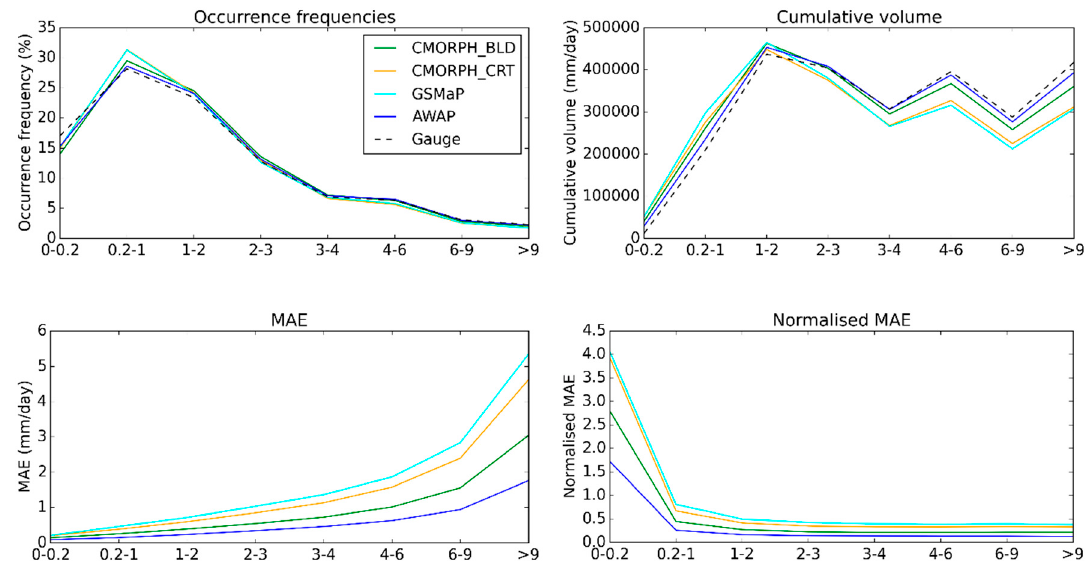
Figure 10. Point-based comparison categorised by rainfall intensities from January 2001 to December 2018 using station gauges as truth. Occurrence frequencies, cumulative volumes, mean average error (MAE), and normalised MAE are